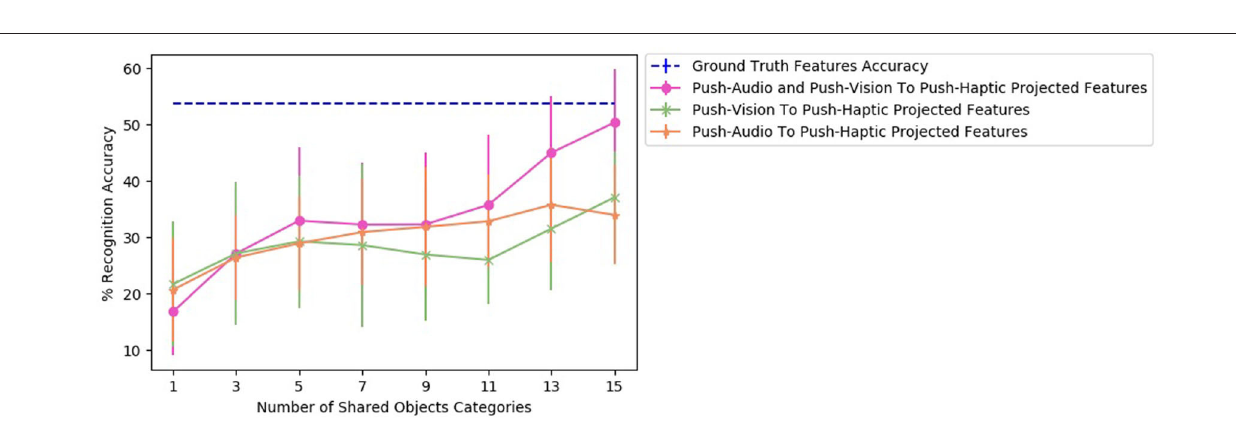
FIGURE 9 | Accuracy achieved by the projected features of the robot for different number of shared objects classifier for β -VAE push-audio and push-vision to push-haptic projection, β -VED push-vision to push-haptic projection, and β -VED push-audio to push-haptic